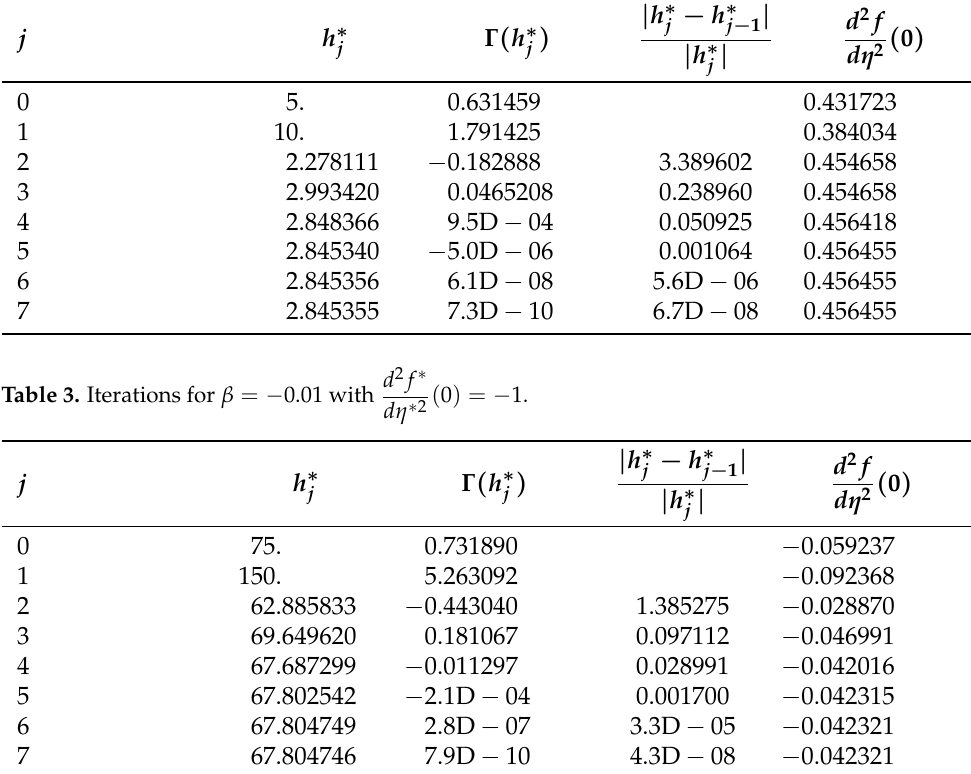
Table 2. Iterations for β = − 0.01 with means a double precision arithmetic.